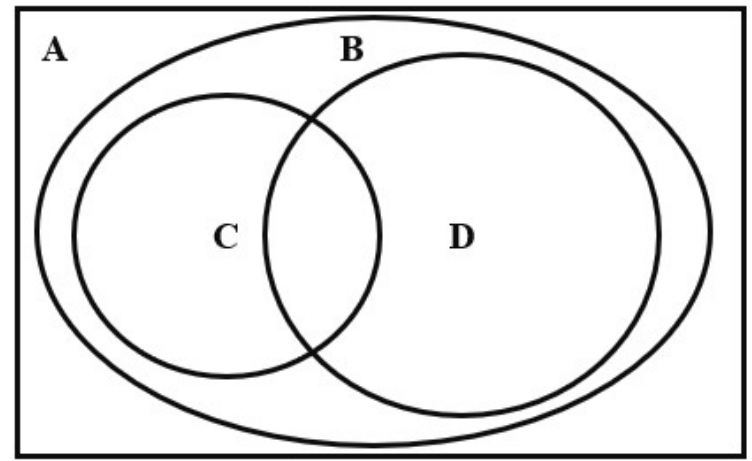
Figure 1. The relationship and di ff erence in di ff erent definitions of public-health expenditure. Note: A indicates the national health spending (the first type of public-health expenditure), B indicates total government health spending (the second type), C indicates the narrow-caliber public-health expenditure (the third type), D indicates the medical service expenditure, C + D indicates the wide-caliber public-health expenditure (the fourth type).